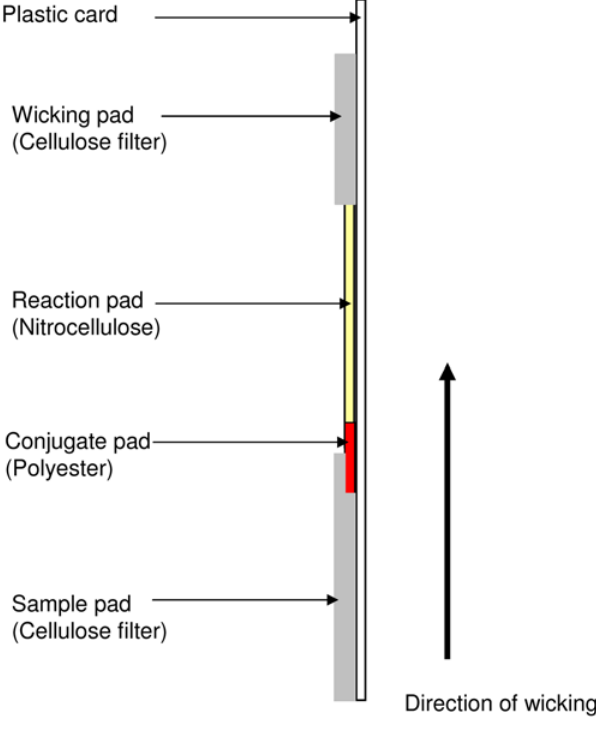
Figure 1. Different components of the dipstick.